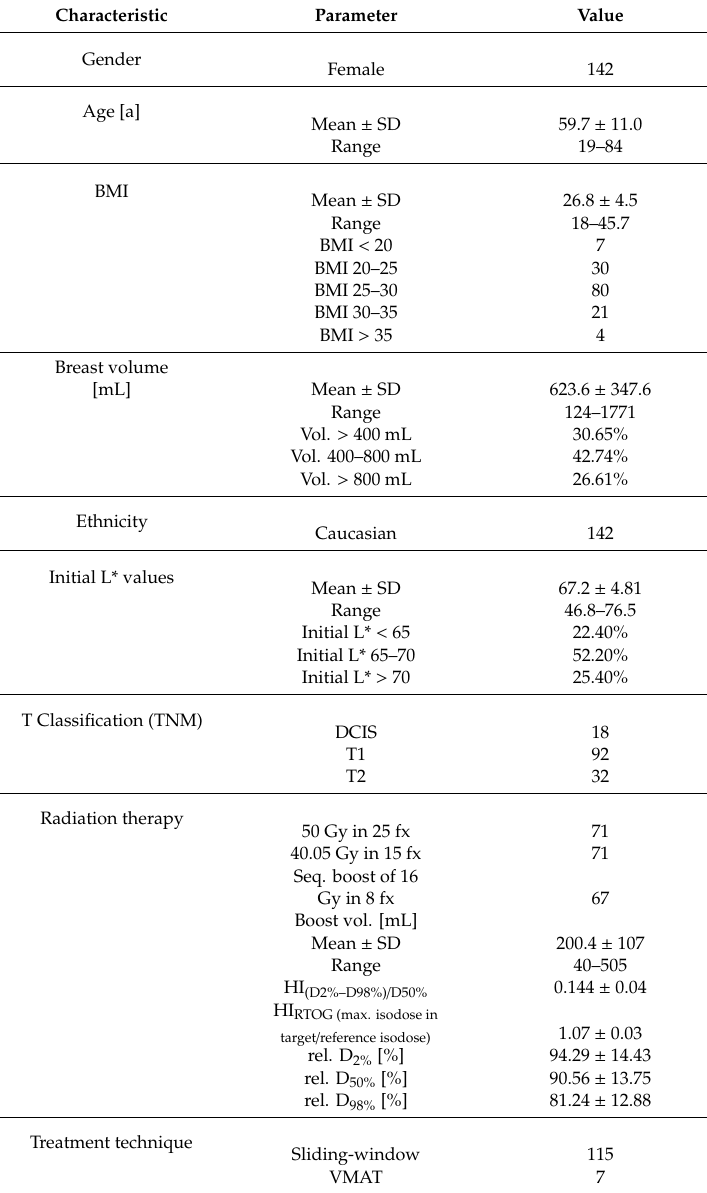
Table 1. Baseline patient, tumor, and treatment